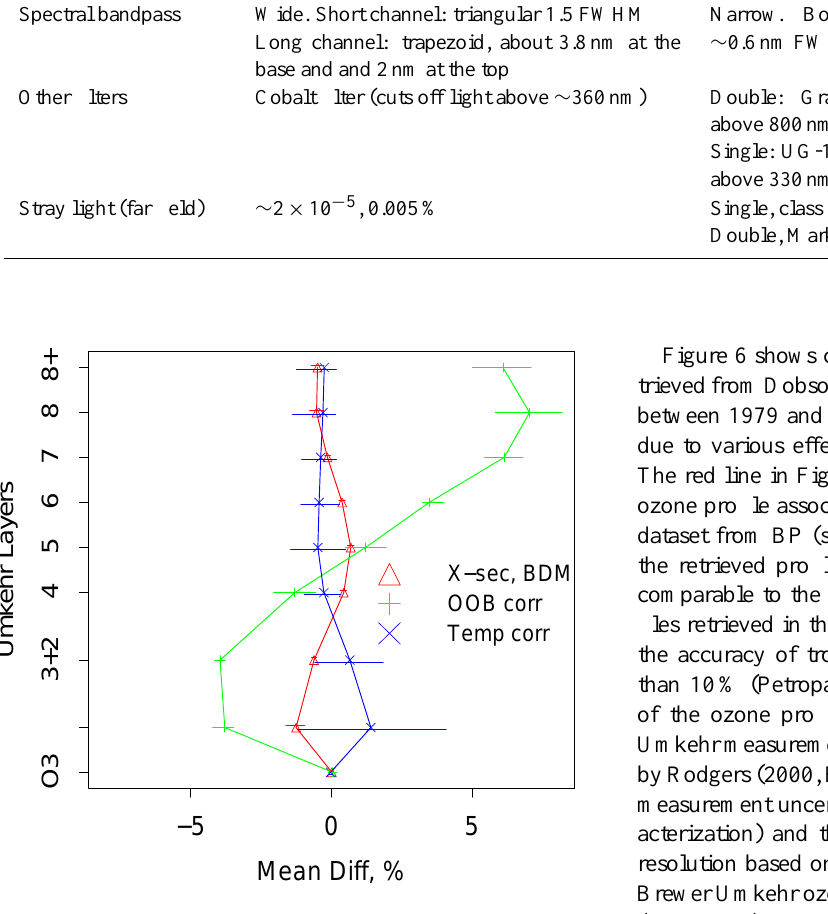
Fig. 6. Ozone profile changes (% relative to the standard retrieval) retrieved from the Dobson No. 65 measurements in Boulder, CO between 1979 and 2008. The range of data is shown with horizontal lines. Changes in the Umkehr ozone profile are due to the use of the BDM cross-section in place of BP (red), neglect of the stray light contribution (green), and temperature variability in climatological temperature dataset (dark